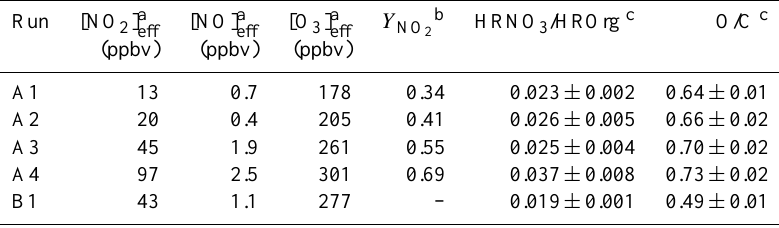
Table 3. Effective concentrations of NO 2 , NO, and O 3 during SOA formation and the chemical properties of the SOAs.